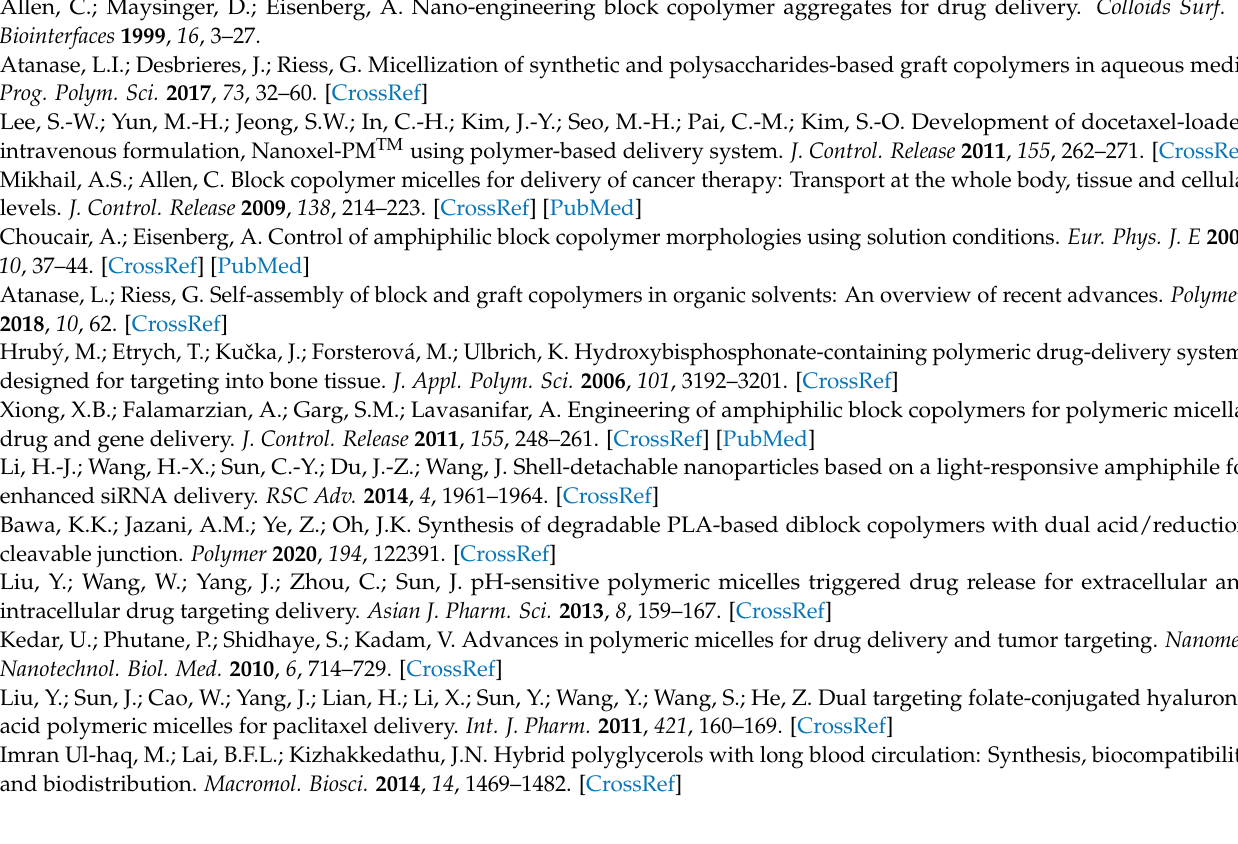
copolymers, Figure S2: 1 H (left) and 13 C (right) NMR spectra of the MPEO 44 - b -PCL 17 diblock copolymer in CDCl 3 , Figure S3: SEC chromatograms in THF of MPEO 44 - b -PCL 17 diblock copolymer (black line), α -methoxy- ω -hydroxy-poly(ethylene oxide) macromer containing a ketal group (blue line) and the MPEO 44 - b -PCL 17 diblock copolymer after degradation (phosphate buffer saline) at pH ~5.0 for 48h (red line). Figure S4: 13 C NMR spectra of MPEO 44 - b -PCL 17 diblock copolymer (top) before degradation and (bottom) after degradation, Figure S5: Cell viability of HeLa cell line after 24 h (black squares) and 48 h (red circles) incubation with different concentrations of drug-free MPEO 44 - b -PCL 17 diblock copolymer